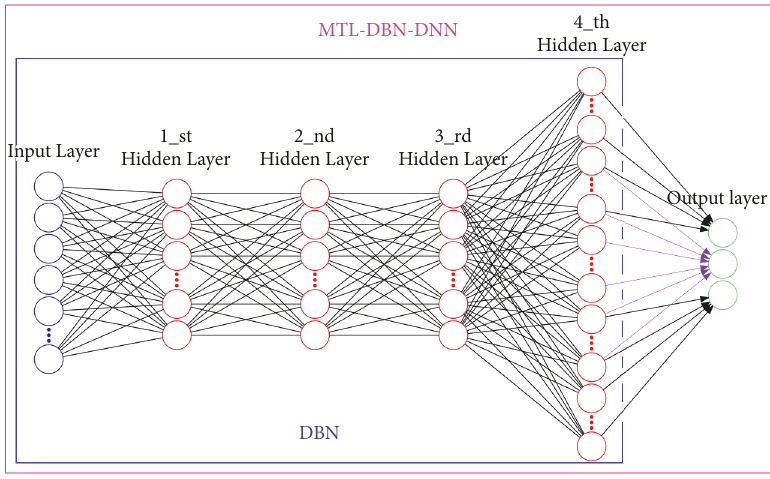
Figure 3: The schematic representation of the DBN-DNN model with multitask learning.